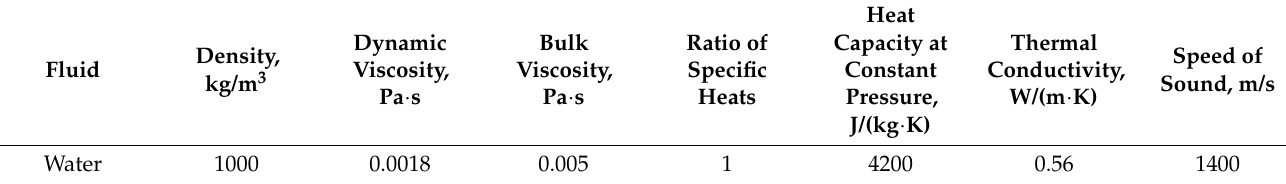
Table 2. Thermophysical properties of fluid